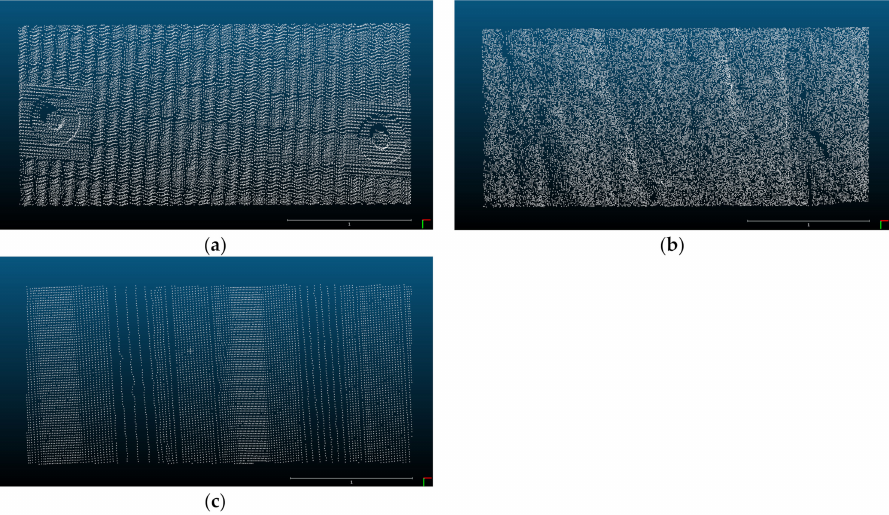
Figure 3. Equivalent cutting of point clouds, ( a ) Concrete panel, ( b ) Soil mixing wall, ( c ) Sheet pile.